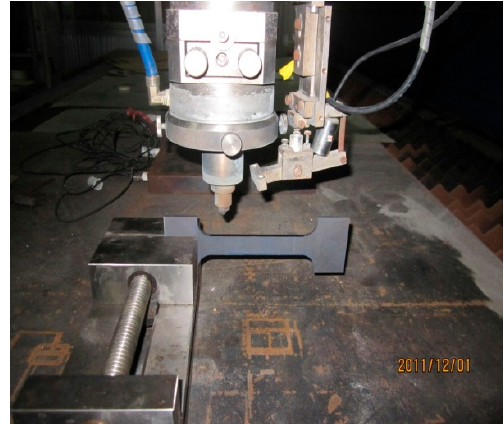
Figure 2. Picture of the SLCF-X12x25 laser system.